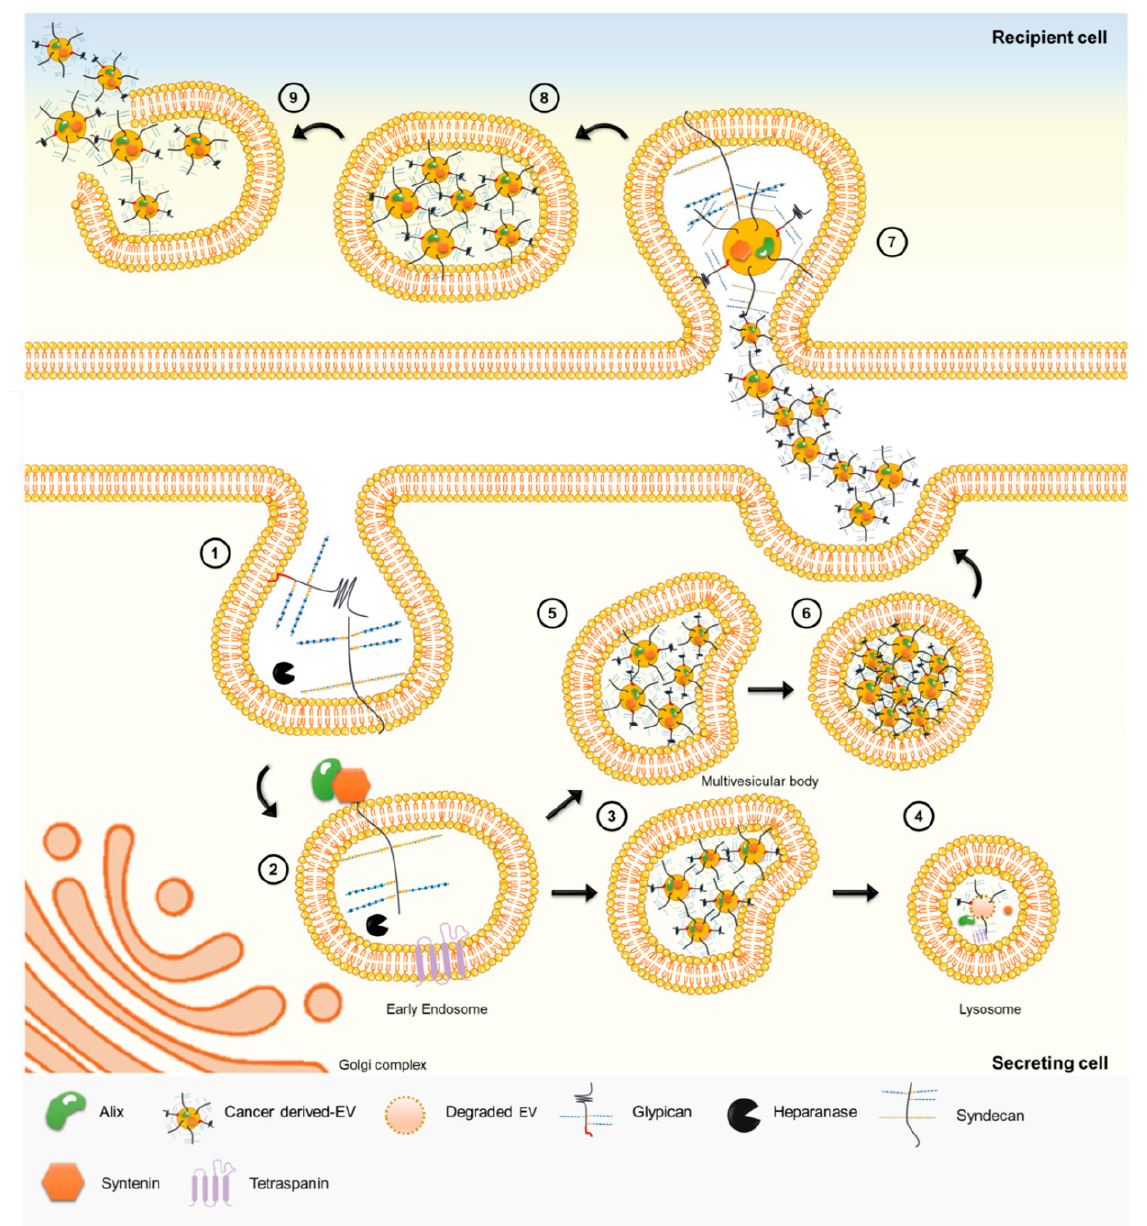
Figure 3. Heparan sulfate proteoglycans regulate EV biogenesis and uptake. ( 1 ) Cell surface HSPGs can bind multiple ligands through their GAG chains [9]. GAGs can be modified by heparanase activity [174]. ( 2 ) Syndecan is internalised through endocytosis process, leaving the cytosolic domain clear for syntenin and Alix proteins binding [160,171]. The early endosomes generate the MVBs by inward budding of theirmembrane. ( 3 ) EVs, particularly those enriched in tetraspanin-6 (TSPN6), can end on lysosome [10] ( 4 ) with consequently degradation of their content. ( 5 ) Alternatively, EVs generated inside of the MVBs can be expelled from the secreting cell, through exocytosis. ( 6 ) After fusion with cellular membrane EVs are released to the extracellular milieu. ( 7 ) HSPGs, and specifically GAGs, are important receptors of the cell membrane-EV surface cluster and are directly involved in EV uptake by recipient cell [116]. ( 8 ) After, the complex is internalised by the recipient cell. ( 9 ) EV-endosome membrane fusion occurs, and EV content is released to cytoplasmic compartment of the recipient cell, and new biological information is transferred [162].